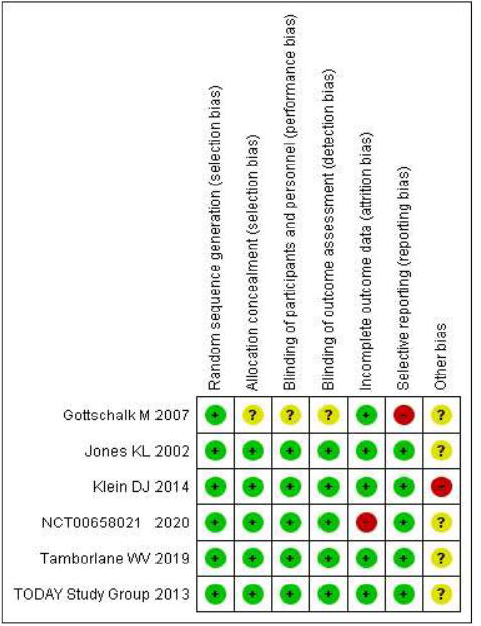
Figure 3. Summary of the bias report. The green color indicates low risk of bias, yellow color indicates Figure 3 . Summary of the bias report . The green color indicates low risk of bias, yellow color indi- cates unclear risk of bias and red color indicates high risk of bias. unclear risk of bias and red color indicates high risk of